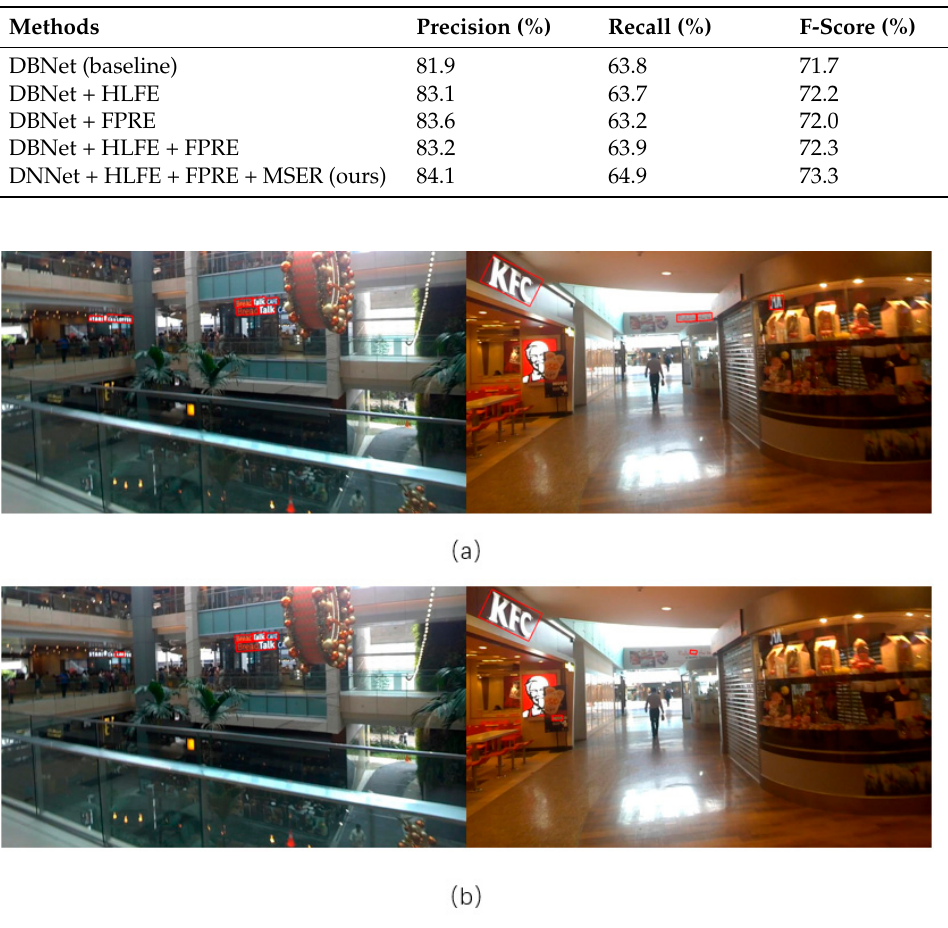
Figure 10. Comparison of visualization results between the method proposed in this paper and the original DBNet model on the ICDAR2015 dataset: ( a ) is the result of the proposed method in this paper, and ( b ) is the result of the original DBNet model.